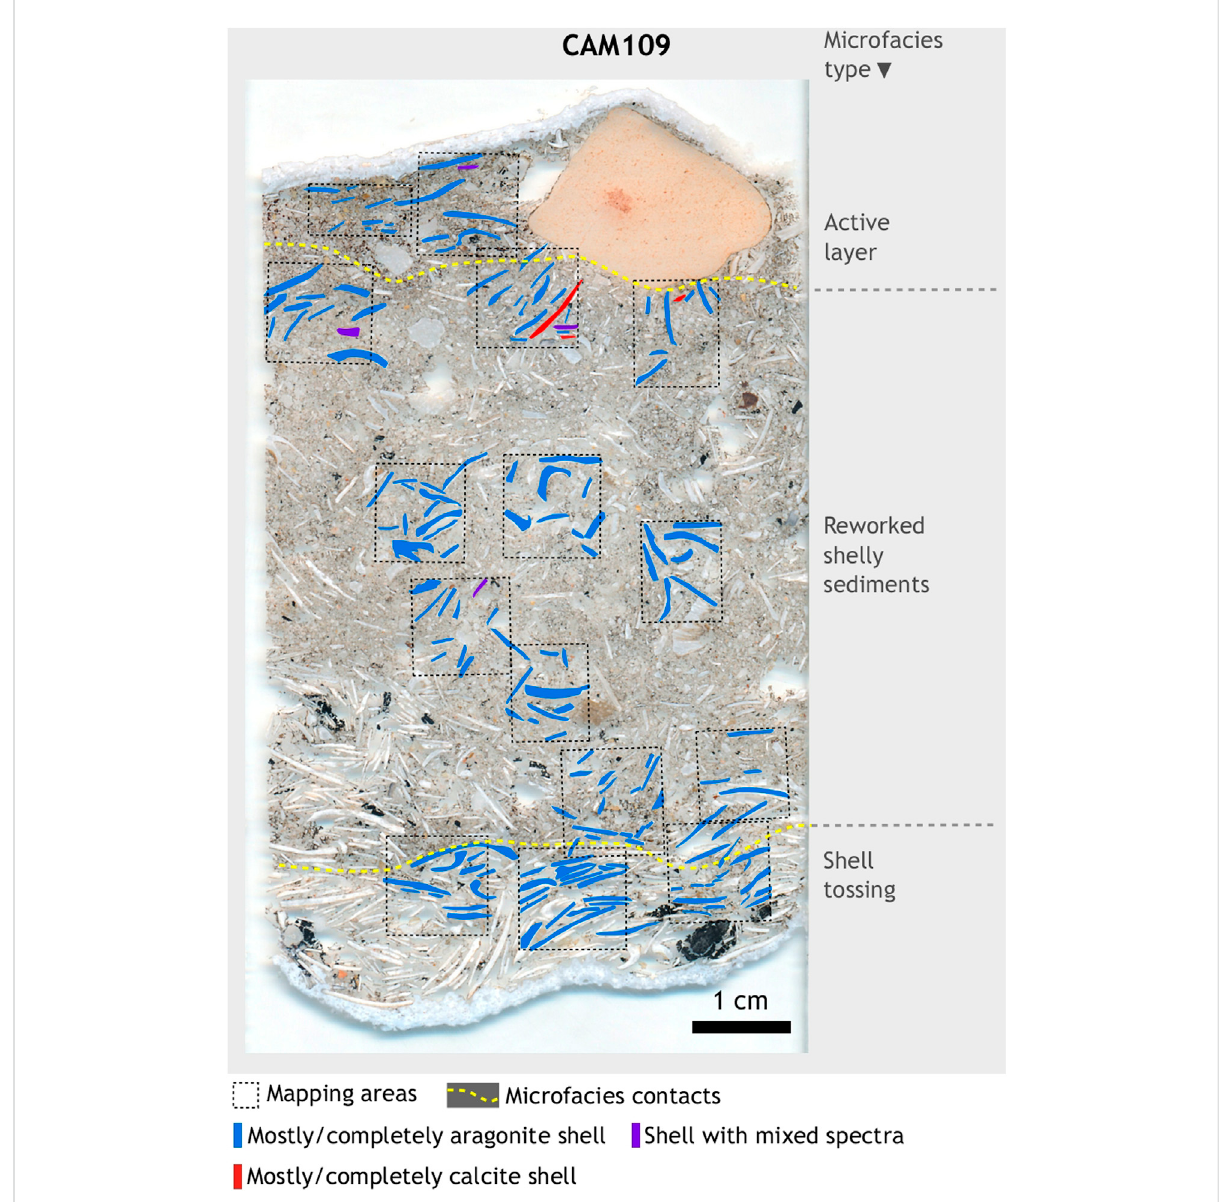
FIGURE 6 Thin section scan of sample CAM109 showing individual shells ’ overall mineralogy obtained through